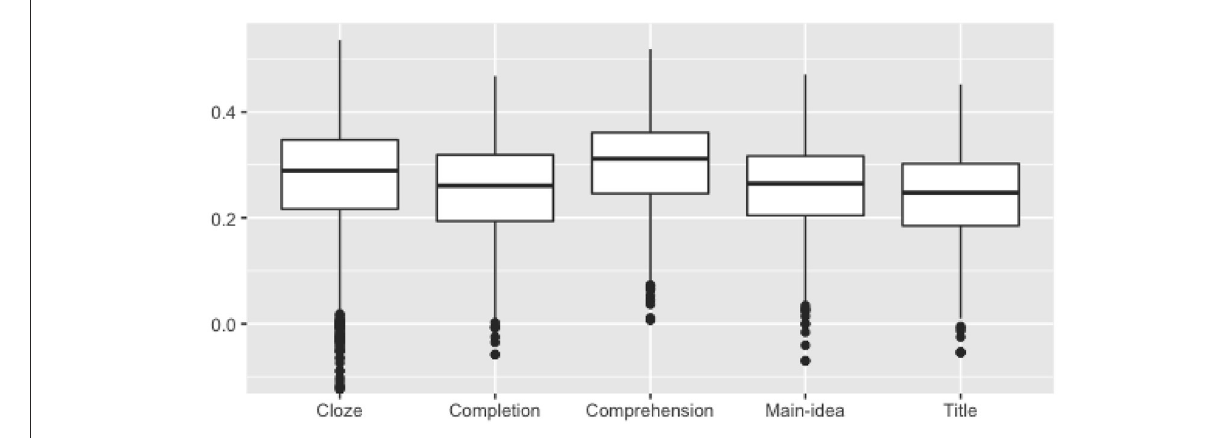
FIGURE3 Item-total correlations with total practice test score.